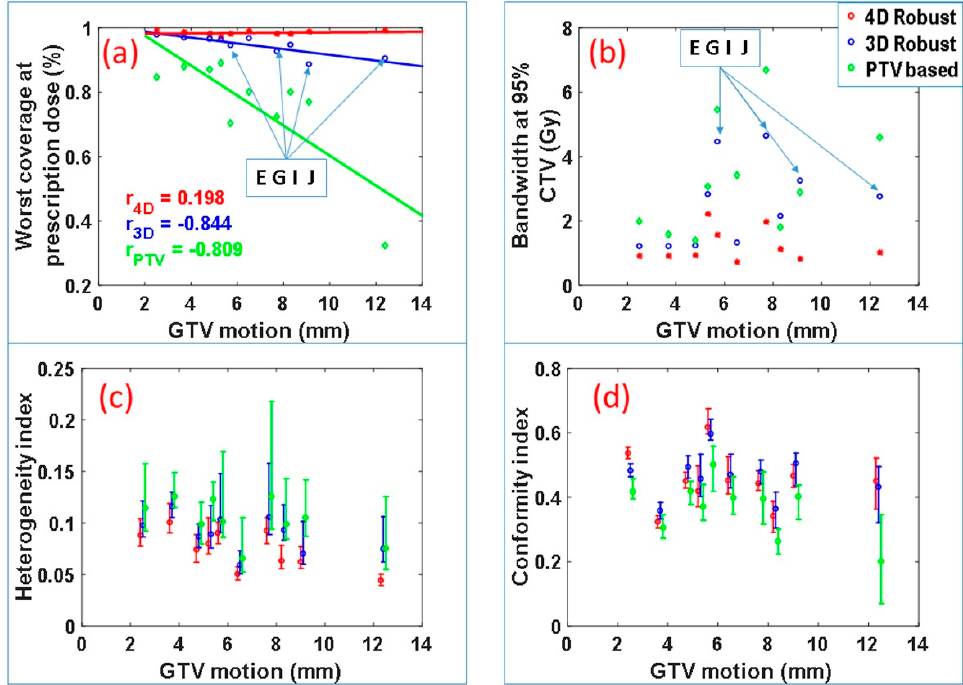
Figure 2. ( a ) Worst-case CTV coverage at prescription dose and ( b ) plan robustness in terms of DVH band widths at 95% of the CTV as a function of GTV motion for 4DRO, 3DRO and PTV-based optimization approaches. Diaphragm intrudes in one or more proton beams for patient E, G, I, J. Panels ( c , d ) show the range and median value of heterogeneity and conformity indices respectively.